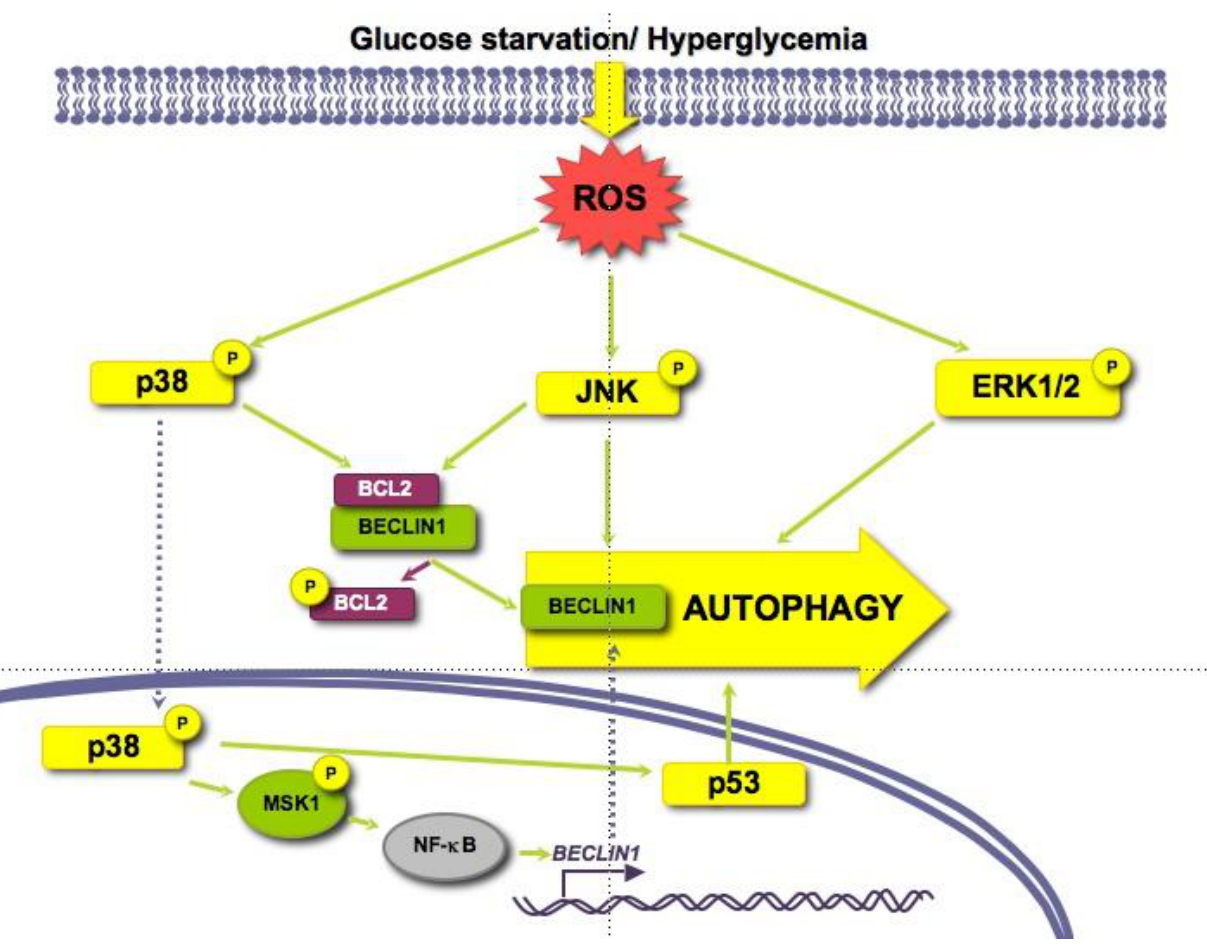
Figure 3. Role of oxidative stress dependent